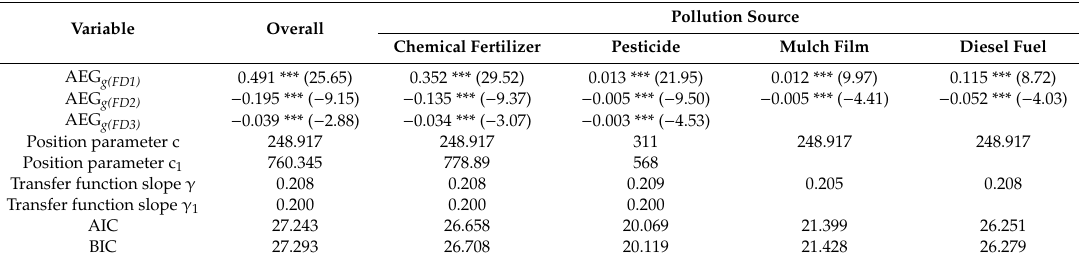
Table 4. Estimation results of the PSTR